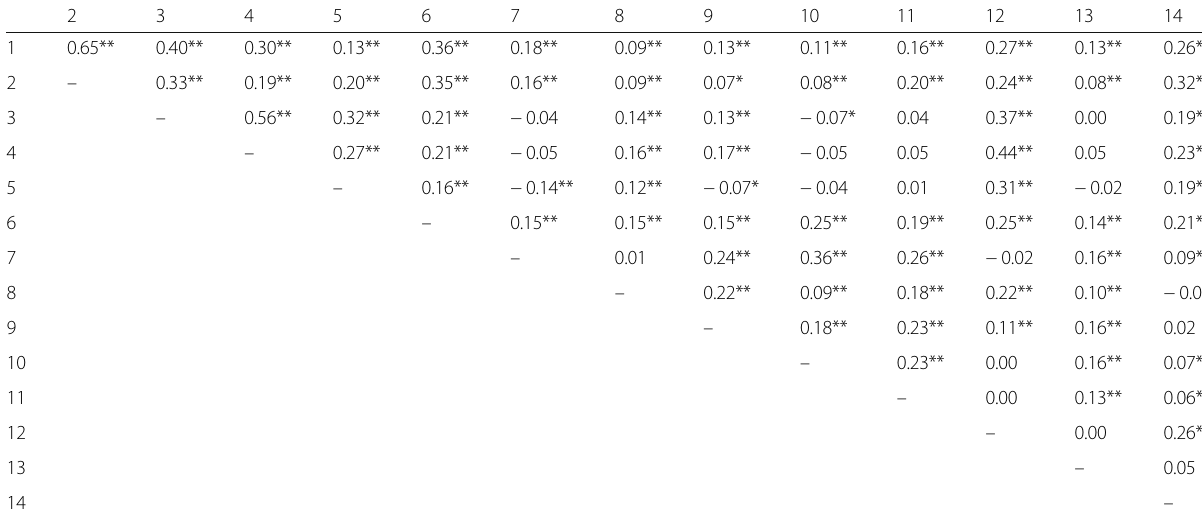
Table 6 Correlation matrix for the 14 coping dimensions model 1 ( n =